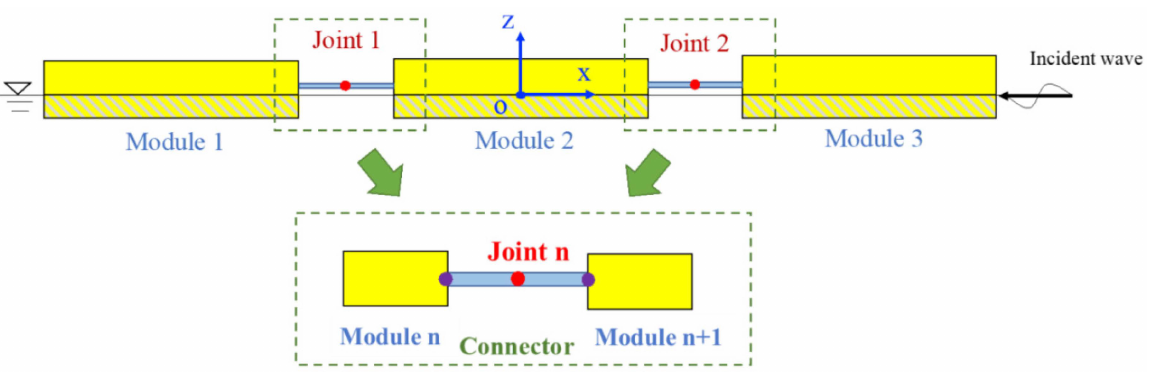
Figure 4. Plan view of the system and connector